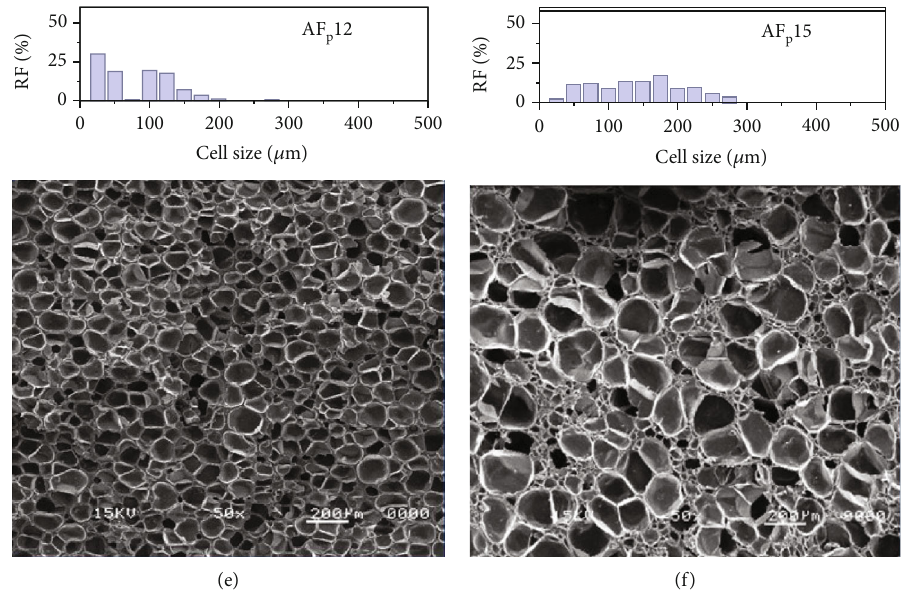
Figure 3: SEM micrographs of the composite foams at di ff erent AF 12wt. %, and (f) 15wt.